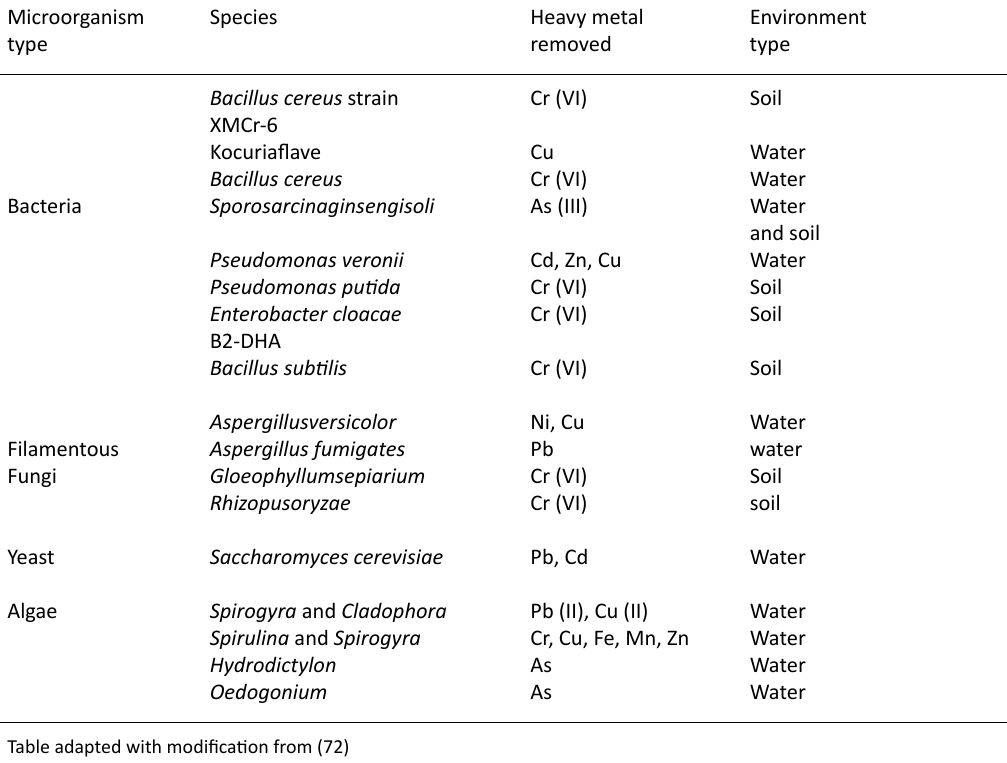
table 1. Microorganisms species that have successfully used to remove heavy metals from contaminated environments